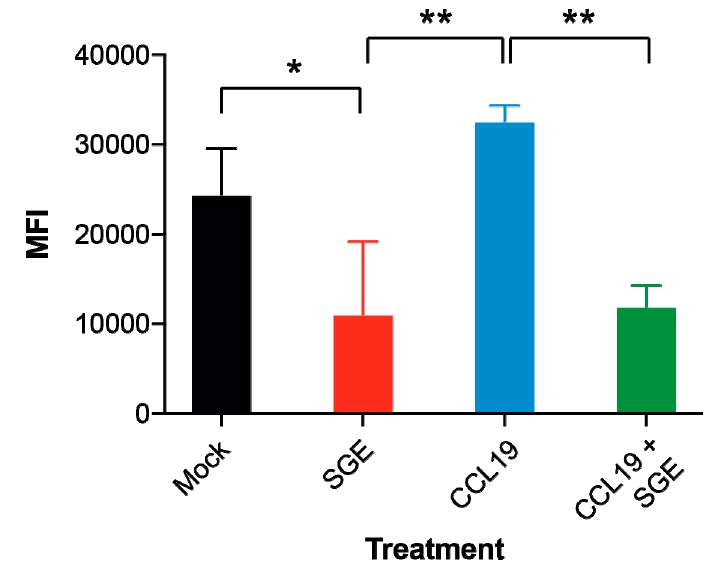
Figure 4. Salivary gland extract from Hyalomma ticks inhibits migration of human monocyte-derived dendritic cells (moDC). moDC migration was studied in a trans-well migration assay. When moDC where exposed to salivary gland extract (SGE) fewer cells migrated to the other side of the trans-well (mock = RPMI only) or with chemoattractant (CCL19). Number of migrated cells was assessed by lysing cells and analyzing DNA content by intercalating dye. Fluorescent was measured as mean fluorescent intensity (MFI). Significance between mock and indicated treatment groups at p < 0.05 and p < 0.01 is designated with one or two asterisk (*) symbols, respectively.